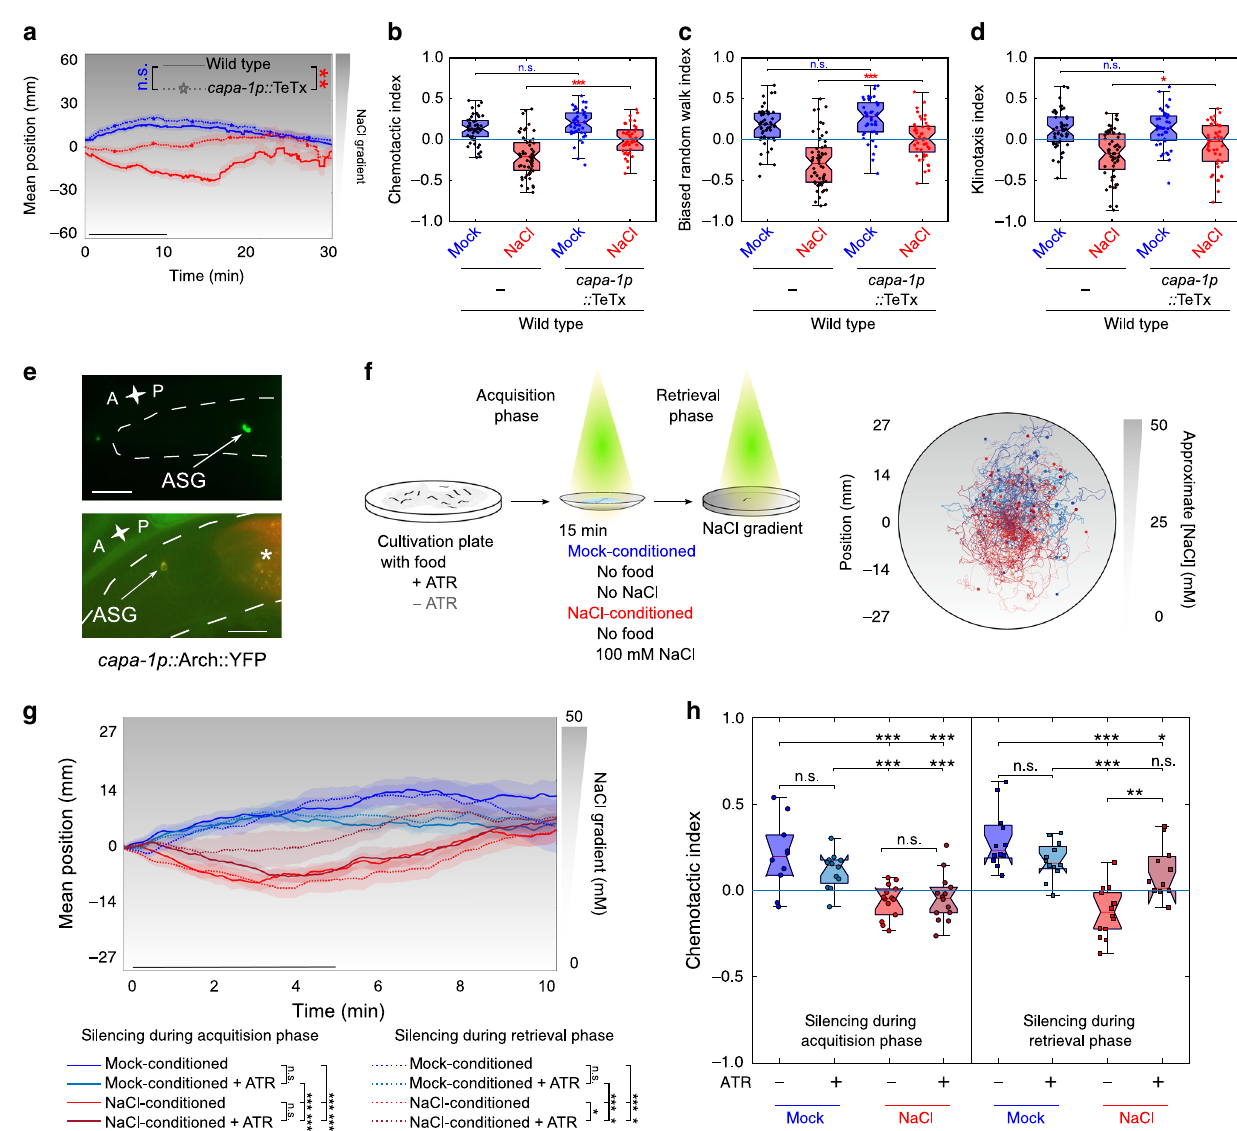
Fig. 7 Silencing CAPA-1 neurons during retrieval of learned salt aversion attenuates NaCl-conditioned behavior. a – d Mock- and NaCl-conditioned behavior of animals expressing the tetanus toxin light chain (TeTx) in ASG, which blocks synaptic release 63 ( capa-1p::TeTx::mCherry ). a Mean population position, b chemotactic, c biased random walk, and d klinotaxis indices on a 0 – 100 mM NaCl gradient after mock- or NaCl-conditioning. From left to right n = 51, 59, 43, 44 animals per condition. Results con fi rmed with a second independent strain (not shown). e The inhibitory opsin Arch expressed as Arch:: YFP under control of the capa-1 promoter (top panel) co-localizes with ASG-speci fi c mCherry expression 43 (bottom panel). Scale bar, 20 µ m. f Optogenetic silencing of ASG. Individual worms are illuminated with yellow – green light for silencing CAPA-1 neurons during conditioning (acquisition phase) or during the NaCl chemotaxis assay when worms are navigating a linear NaCl gradient (retrieval phase) (see Methods for details). Arch requires supplementation of the cofactor all-trans retinal (ATR) to the worm culture. Transgenic C. elegans not fed ATR-supplemented food serve as a negative control. After conditioning, worms are put in the middle of a chemotaxis plate with a linear NaCl gradient (0 – 50 mM) and kept in the fi eld-of-view using an automated xy-stage. Right panel shows navigation trajectories of 10 – 14 worms per condition. g Positions of individual worms on the NaCl gradient through time and h chemotactic index. Corresponding biased random walk and klinotaxis indices shown in Supplementary Fig. 10a, b. The time interval for statistical comparison was reduced to 5 min to accommodate the small plate format. g , h From left to right n = 10, 12, 14, 14, 12, 12, 14, 11 animals per condition. Shaded regions on a and g represent S.E.M. while black bars indicate the time interval for calculating the mean gradient position and behavioral indices. Signi fi cances determined by two-way ANOVA with Tukey ’ s HSD post hoc test. n.s. not signi fi cant; * p ≤ 0.05; ** p ≤ 0.01; *** p ≤ 0.001. Boxplots show medians, 25th and 75th percentiles as box limits. The whiskers extend to the most extreme data points not considered as